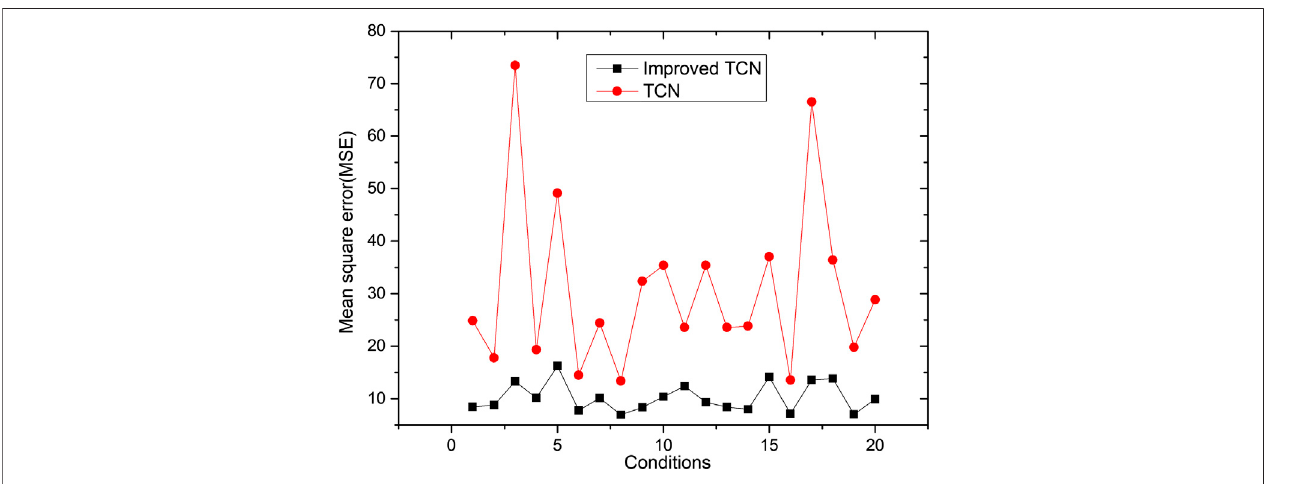
FIGURE 8 | RMSE results of ITCN vs, vanilla TCN under different operating conditions.